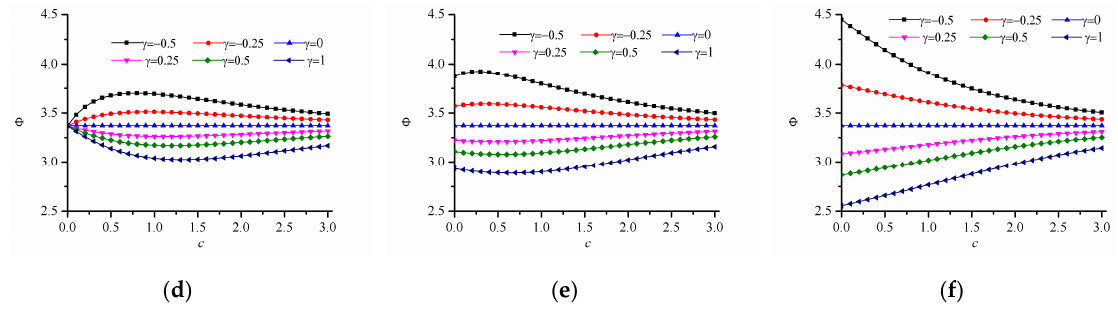
Figure 11. Variation of the failure index with different strength-modulus exponent ratio for the power-law inhomogeneous variation of x-FGM and y-FGM when c > 0. x-FGM: ( a ) δ = 0.0; ( b ) δ = 0.2; ( c ) δ = 0.4; y-FGM: ( d ) δ = 0.0; ( e ) δ = 0.2; ( f ) δ = 0.4.